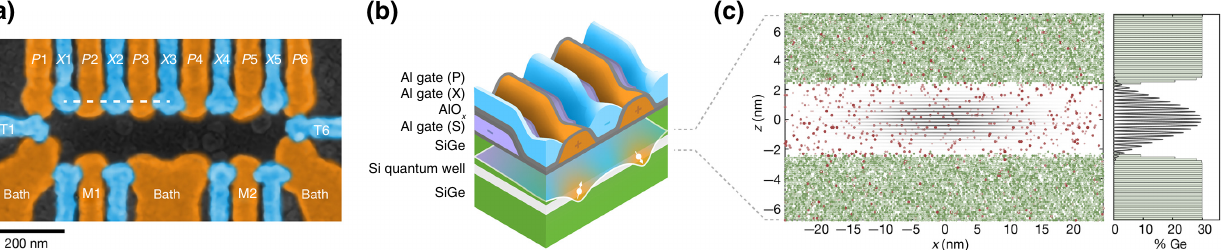
FIG. 1. (a) False-color scanning electron micrograph of a six-dot device. A 2DEG is accumulated under the bath gates, and loaded through the tunnel barriers formed by gates ( T ). The plunger gates ( P ) form the quantum dots and exchange gates ( X ) control the exchange interaction between neighboring dots. The measure dot ( M ) acts as an electrometer, sensing the charge state in each dot through capacitive shift. This work focuses on data from double quantum dots on devices featuring arrays of up to six dots, as highlighted. (b) Sketch of the Si/SiGe heterostructure, as labeled; gate stack, color matched to the white-dashed-line-indicated region of (a), and a depiction of a double-dot potential, which is depressed due to P gates and lifted due to X gates; electrons with spin are depicted as white. (c) Illustration of the Si/SiGe barrier and electron wavefunction of a single dot with population of spin-carrying nuclear spins. The plot places a green circle for each 73 Ge nucleus and a red circle for each 29 Si nucleus in a 50 × 50 × 14 nm 3 slab of material (dot size and shade indicate the distance into the out-of-page y dimension). The dots are randomly placed at each silicon lattice site with probability 800 ppm for 29 Si in both well and barrier and 7.76% for 73 Ge multiplied by the alloy content. The sidewall content of 29 Si is enriched in this figure, but is natural in the actual devices. The alloy content for Ge is shown as horizontal bars on the right, for a profile with 1 atomic layer of smearing at the Si/SiGe interface. This Ge percentage is used to determine the vertical wavefunction | ψ( z ) | 2 , shown in black and featuring valley oscillations with phase determined by Ge placement. A 30-nm-diameter Gaussian wavefunction diameter is assumed in the x and y